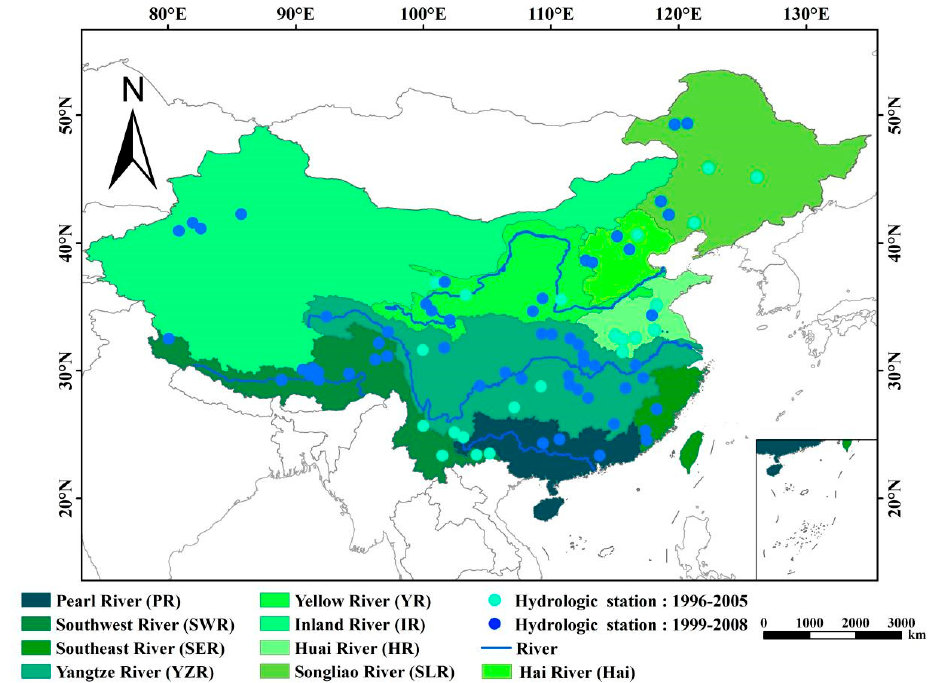
Figure 1. Distribution of the 79 typical stations in the 9 major basins, where dark blue dots indicate data period is 1999–2008 and light blue dots indicate data period is 1996–2005.